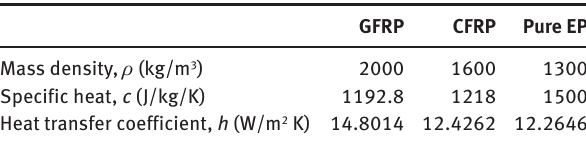
Table 1: Mechanical and thermal properties of the investigated materials.